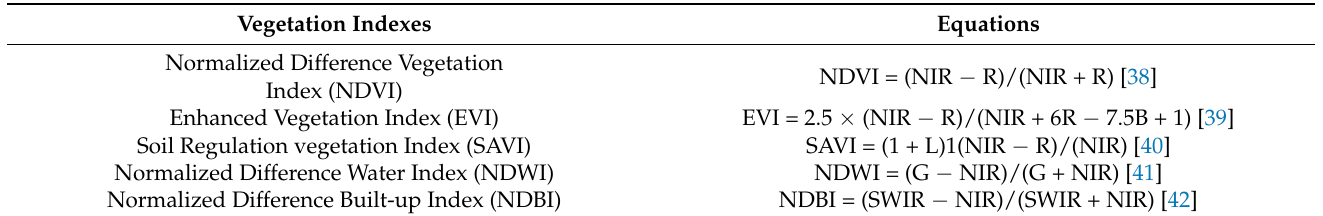
Table 4. B, G, R and NIR are the reflectivity of blue, green, red and near-infrared bands, respectively; L is the soil regulation parameter and has a value of 0.5.